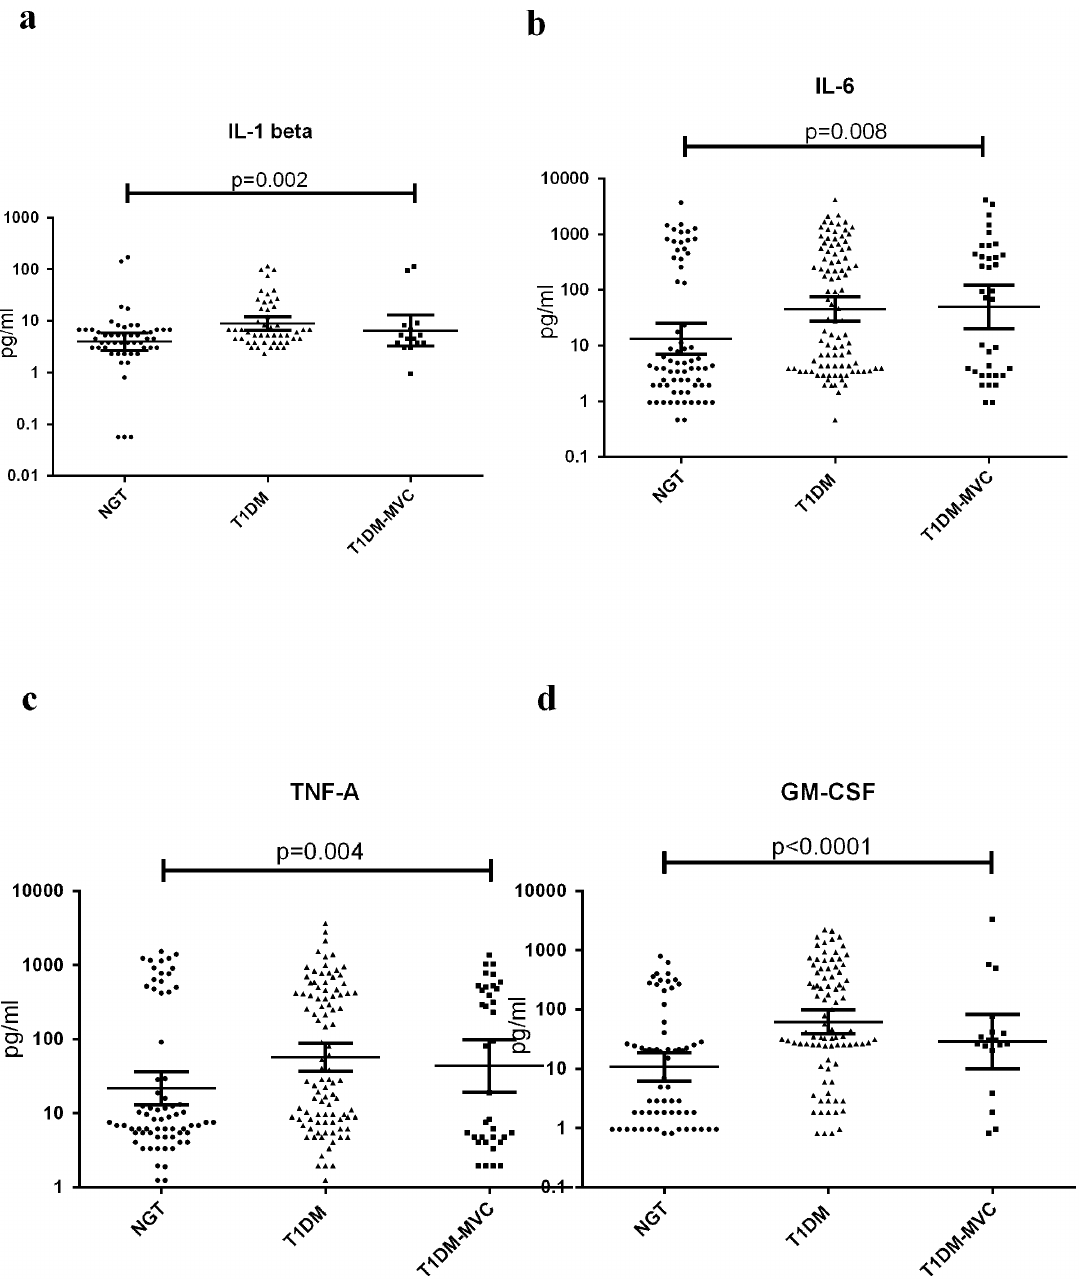
Fig 2. T1DM is characterized by systemic inflammation with high levels of serum pro-inflammatory cytokines. Serum levels of IL-1 β (a), IL-6 (b), TNF- α (c), and GM-CSF (d) were determined in NGT (n = 64), T1DM without MVC (n = 97) and T1DM subjects with MVC (n = 36) by ELISA. Each dot represents individual values with the horizontal line representing the geo mean. Significance was calculated by non-parametric Mann – Whitney U test and p < 0.05 was considered significant. The indicated p values are for pair-wise comparisons.